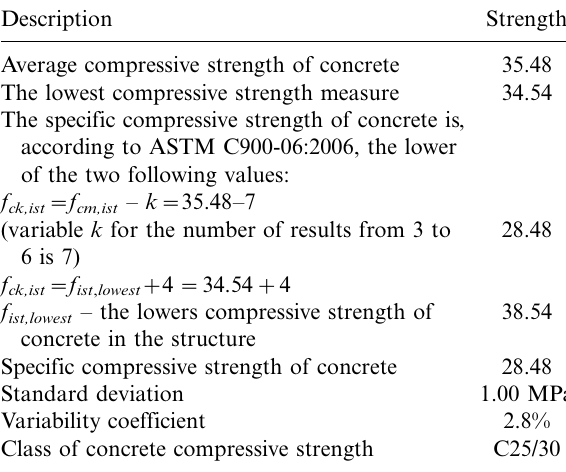
Table 2. Evaluation of real concrete